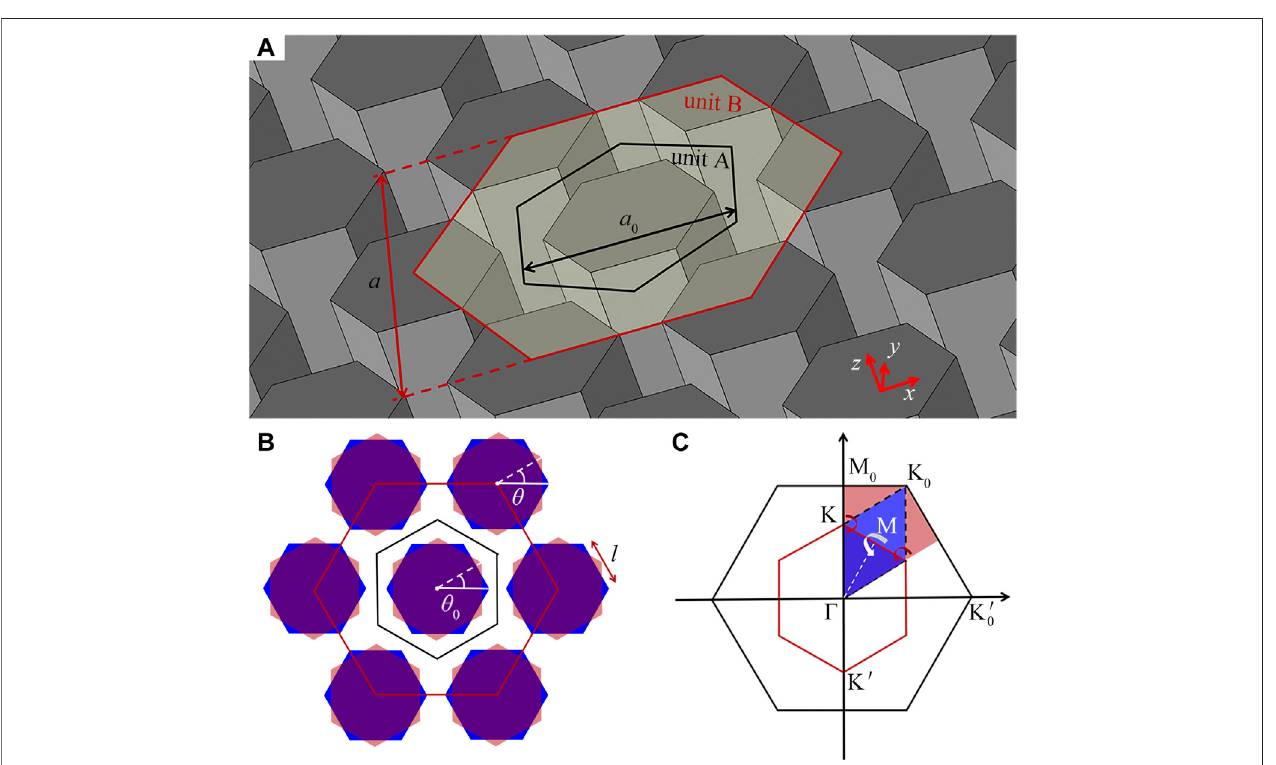
FIGURE 1 | (A) Schematic of an airborne SC composed of regular hexagonal rods. Black and red open regular hexagons refer to the units A and B with the lattice constants a 0 and a , respectively. (B) Schematic of the unit B with two types of con fi gurations. Red regular hexagons exhibit its rotation state, and the parameters θ 0 and θ are the rotation angles of a central rod and six surrounding rods, respectively. Blue regular hexagons represent its riginal con fi guration ( θ 0 (cid:1) θ (cid:1) 0 ° ). (C) Schematic of the folding mechanism of the BZs for the units A and B, corresponding to the black and red open regular hexagons,